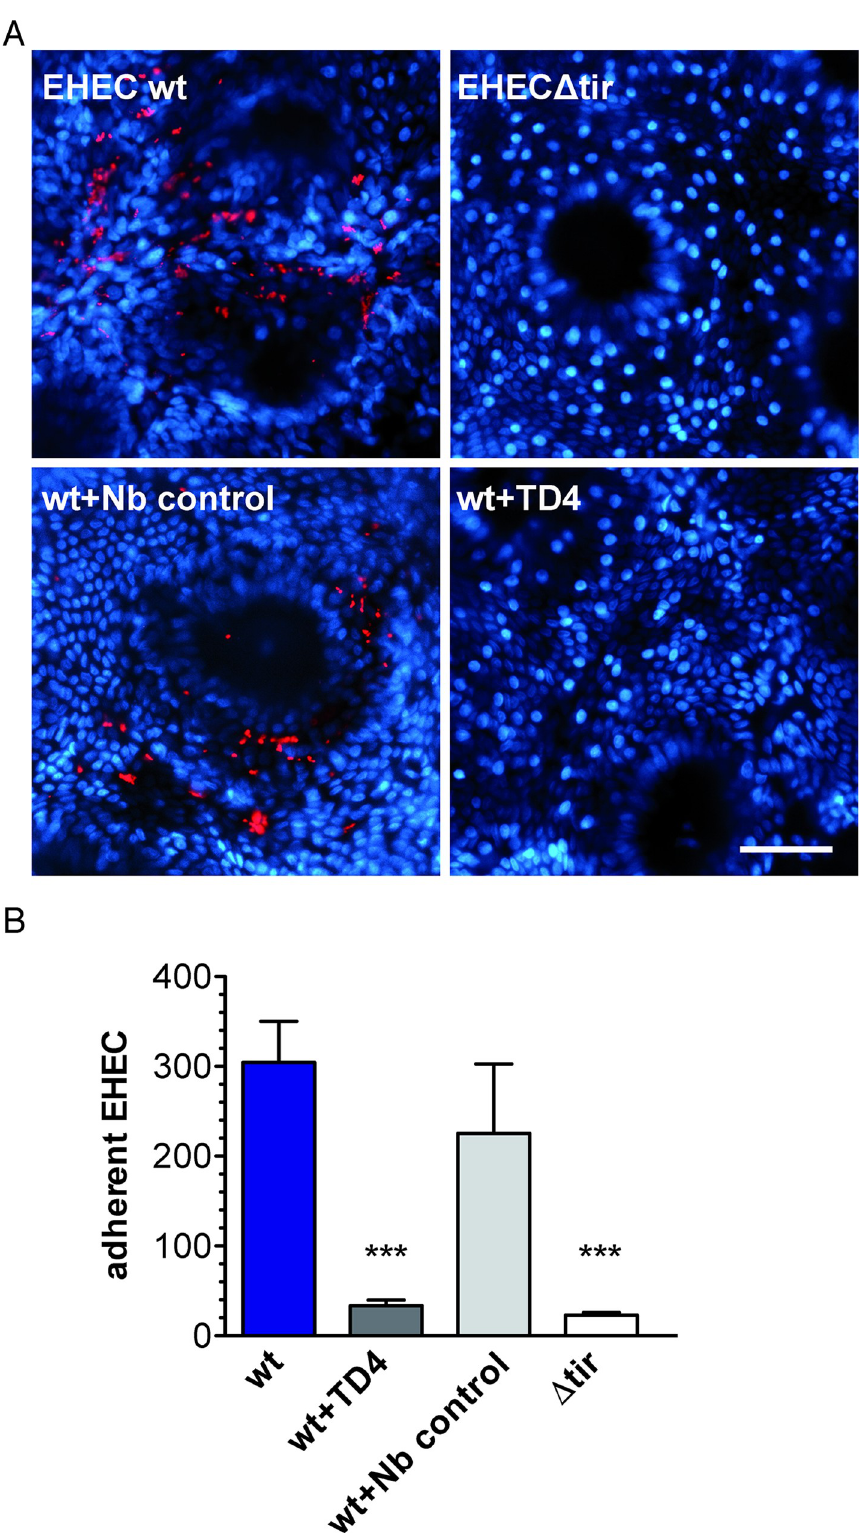
Fig 7. EHEC binding to human colonic biopsies is reduced in the presence of Nb TD4. A . Biopsy samples from the transverse colon were infected for 8 h with EHEC wild-type alone (EHEC wt) or in the presence of 200 nM Nb